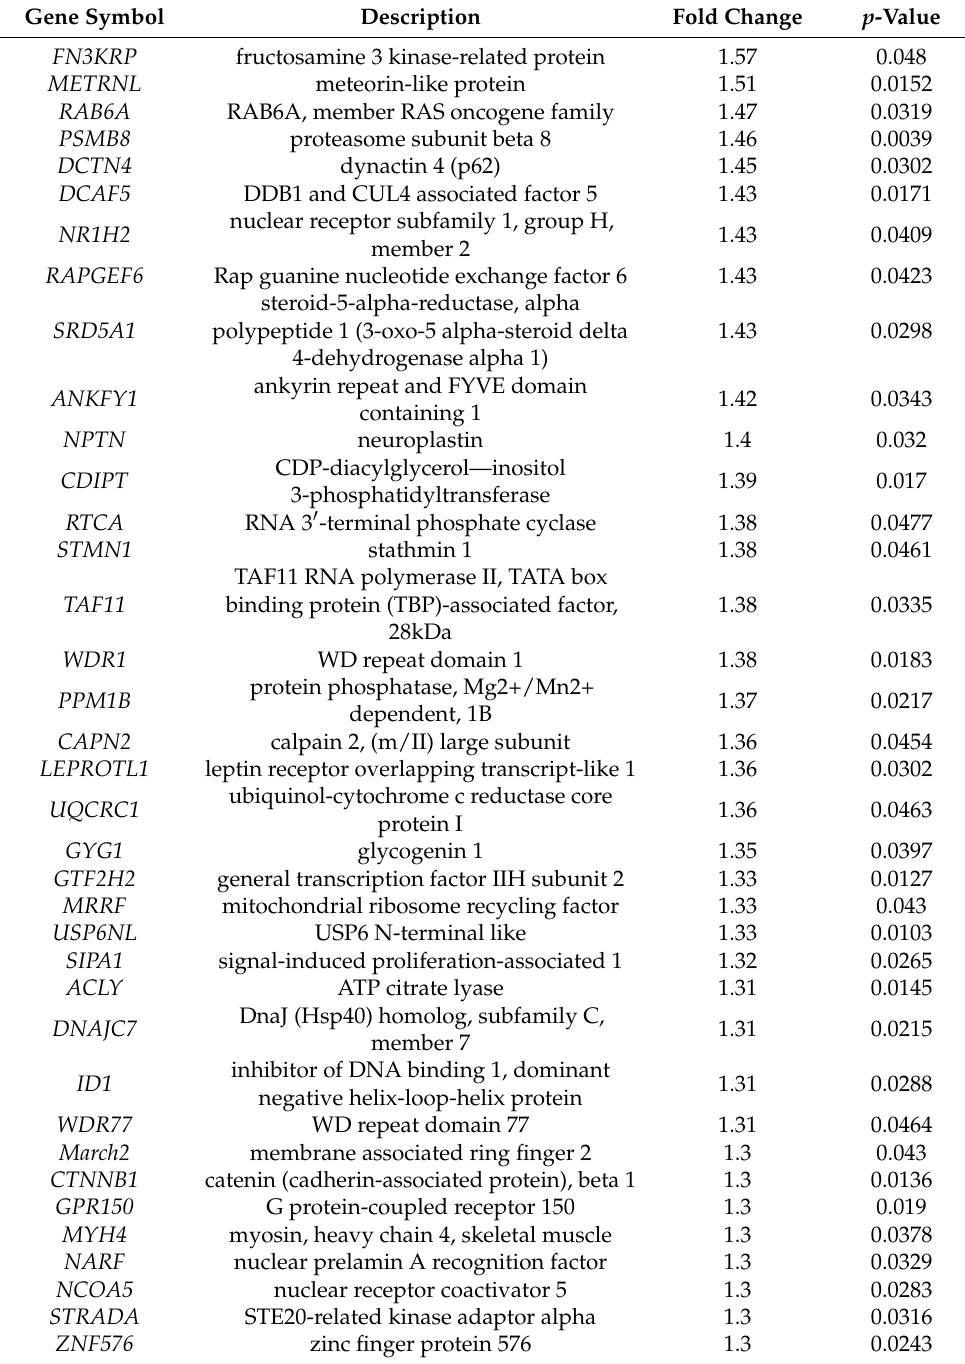
Table 1. List of upregulated genes with fold change >1.3 compared to control